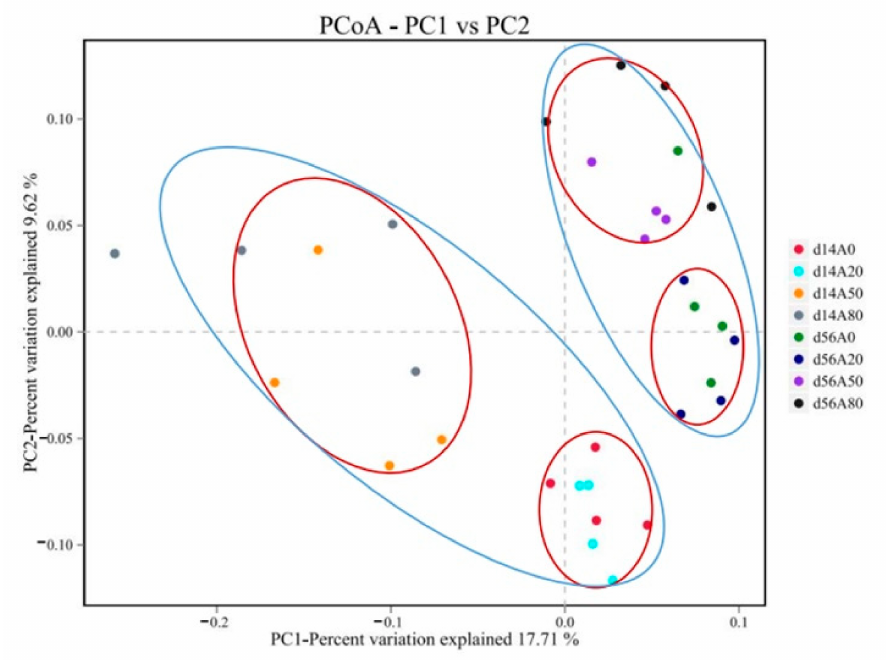
Figure 1. Rumen bacteria principal coordinates analysis (PCoA) of Tibetan